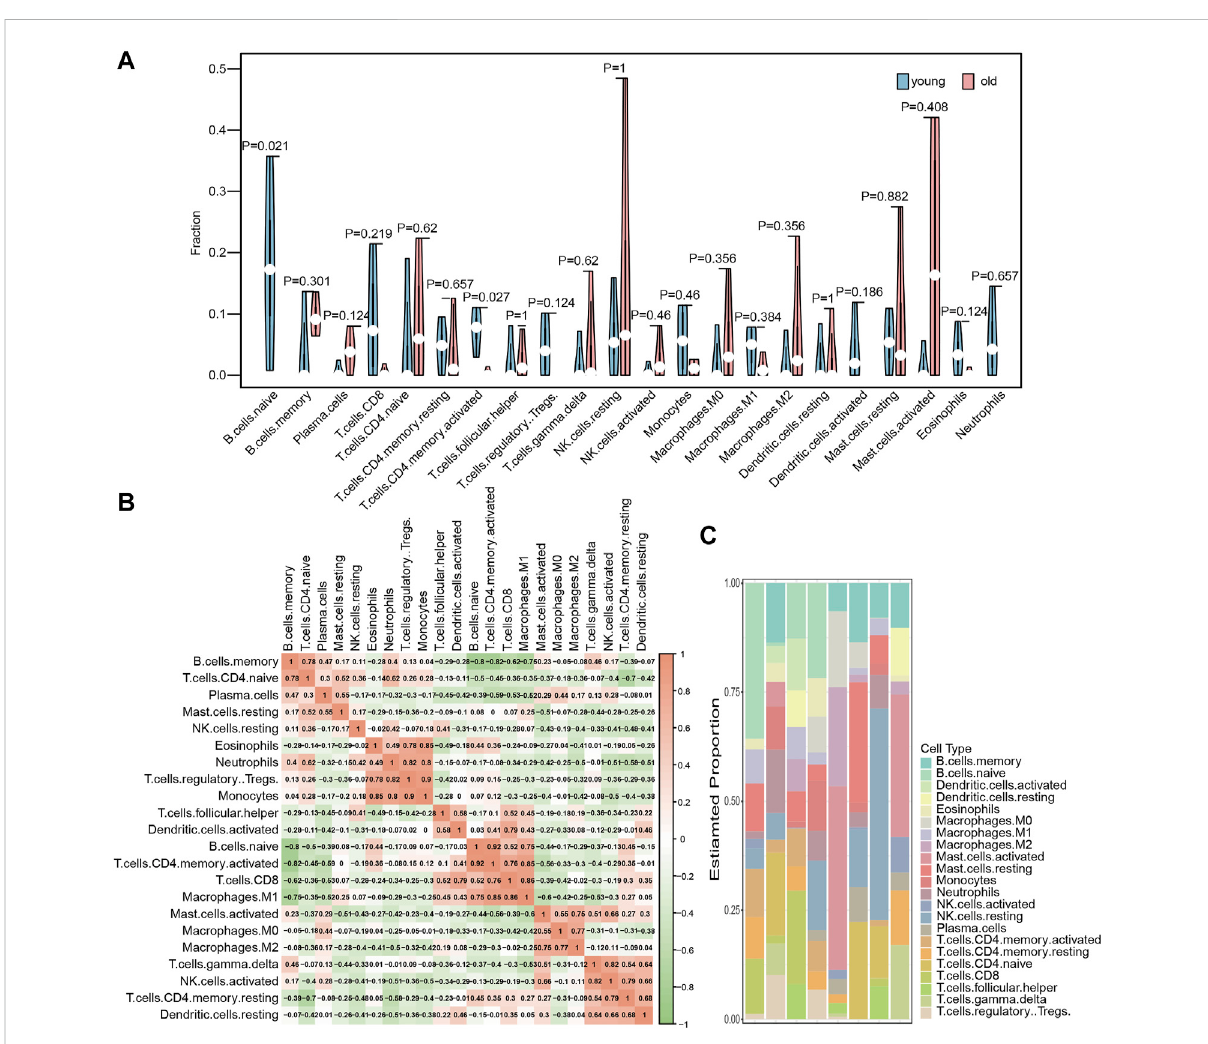
FIGURE 3 Immune cell in fi ltration analysis. (A) Differences in the abundance of 22 immune cell types enriched in the GSE113212 dataset; green indicates the young normal LF group, red indicates the elderly LFH group; the horizontal axis indicates the 22 immune cell types, and the vertical axis the abundance of immune cell in fi ltration. (B) Correlation analysis between the various immune cell types in the GSE113212 dataset; color intensity represents the strength of correlation − the more red or green the color, the stronger the correlation between two immune cell types. (C) Stacked bar graphs of the 22 immune cell types in different samples of the GSE113212 dataset; different color bars represent different immune cell